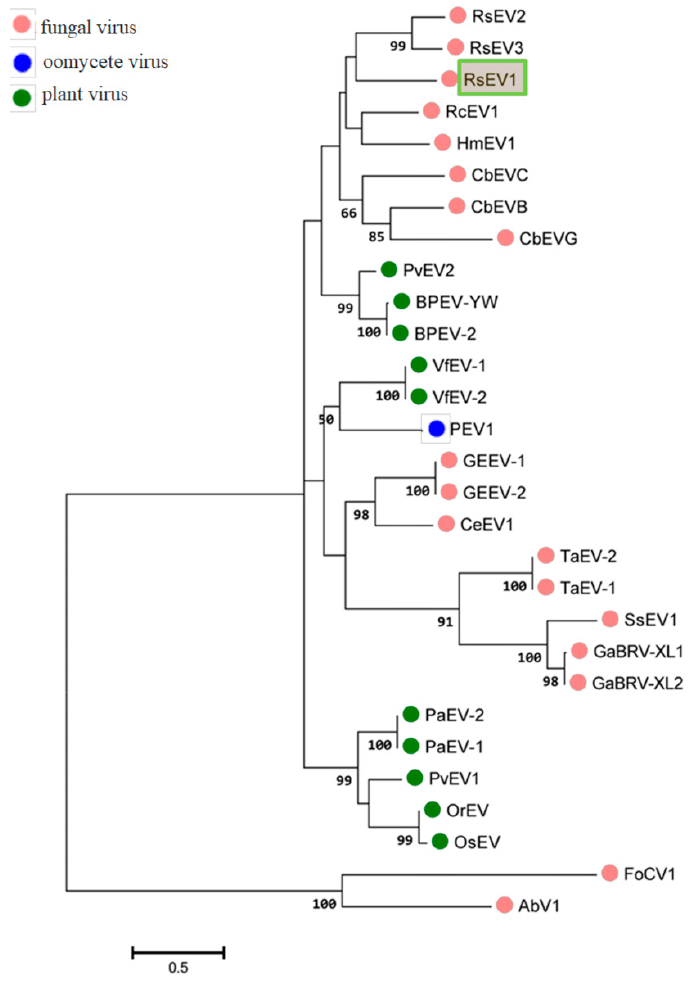
Figure 3. Phylogenetic analysis of RsEV1 and other endornaviruses based on the deduced amino acid sequences of RdRps using the maximum likelihood (ML) method with 1000 bootstrap replicates. The scale bar indicates a genetic distance of 0.5 amino acid substitutions per site. The green box represents the novel mycovirus RsEV1 in this study. The abbreviations of viruses and their GenBank accession numbers are as follows: RsEV2, Rhizoctonia solani endornavirus 2 (AMM45288.1); RsEV3, Rhizoctonia